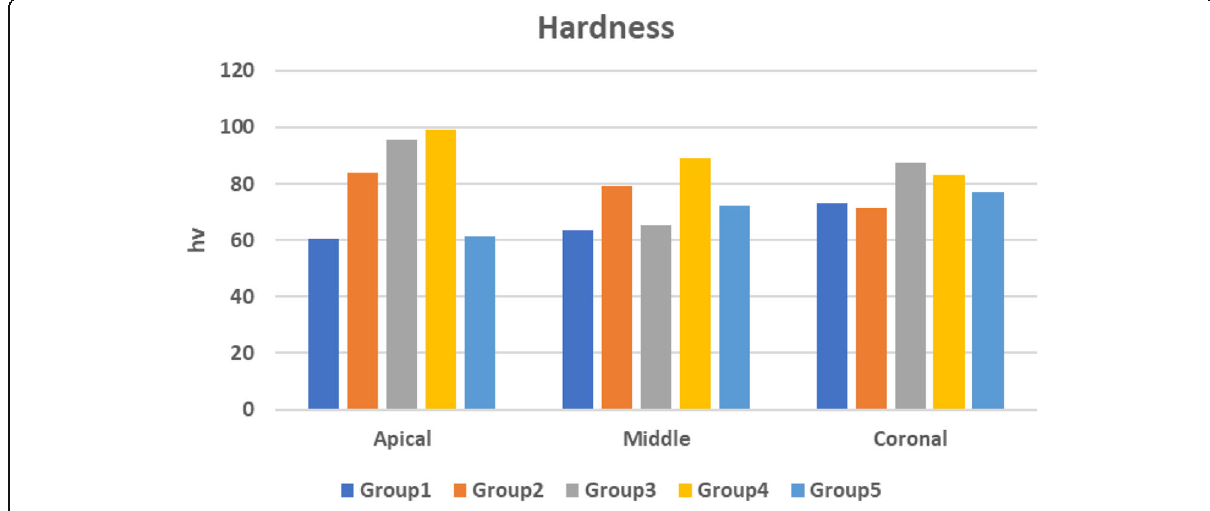
Fig. 1 Histogram showing the microhardness results for each third for all the groups